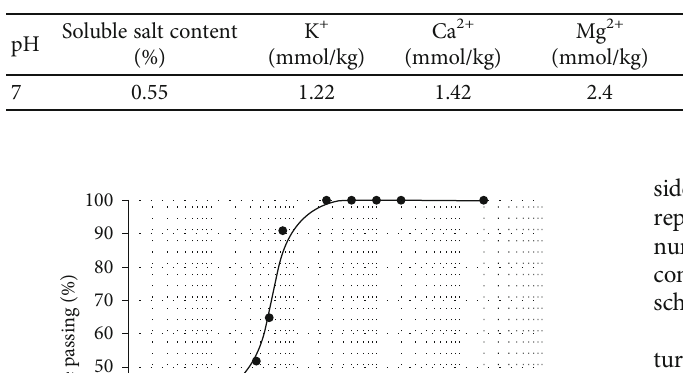
Table 2: Basic chemical properties.